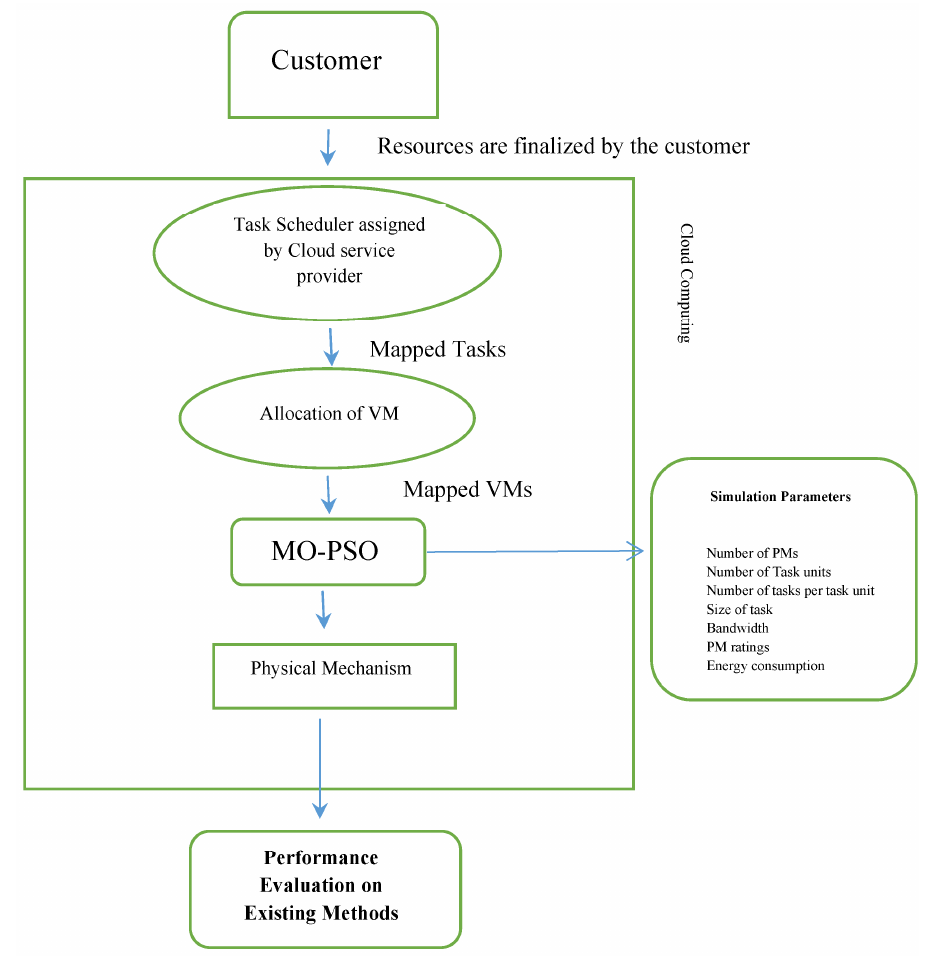
Figure 1. Workflow of multi optimization PSO algorithm.